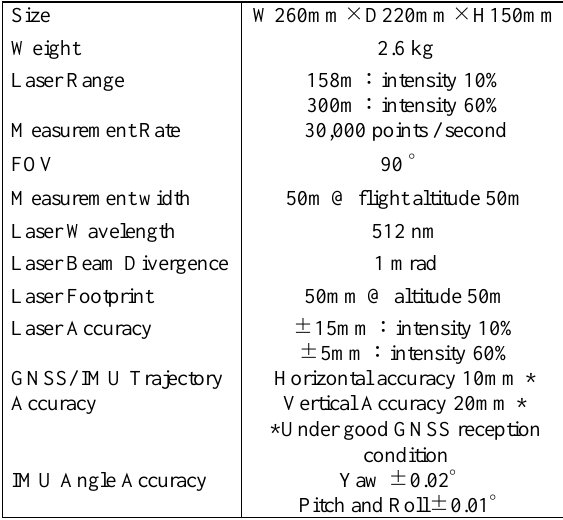
Table 1. The specification of TDOT GREEN GNSS measurement was used GNSS/ IMU trajectory accuracy under good GNSS reception condition. Error of laser scanner was used laser accuracy of intensity 10%. Error due to laser footprint was estimated from laser beam divergence. Error of laser angle measurement was used IMU angle accuracy. From these value, error of entire point cloud was estimated, and was illustrated at Figure 2. It was confirmed that the theoretical measurement accuracy of TDOT GREEN was approximately 40mm at flight altitude of 50m.